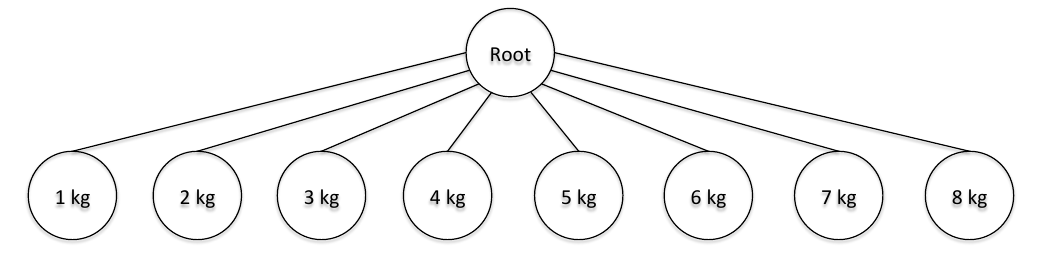
Figure 2. Hierarchical structure of our